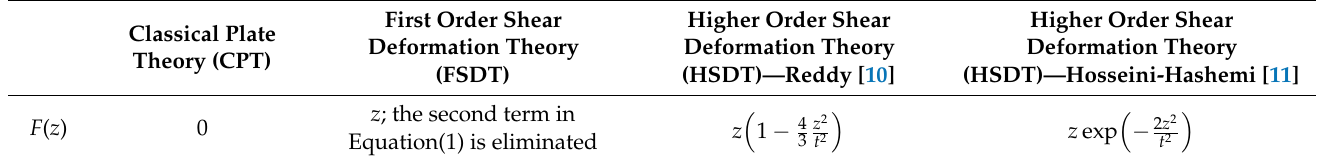
Table 1. Variants of plate